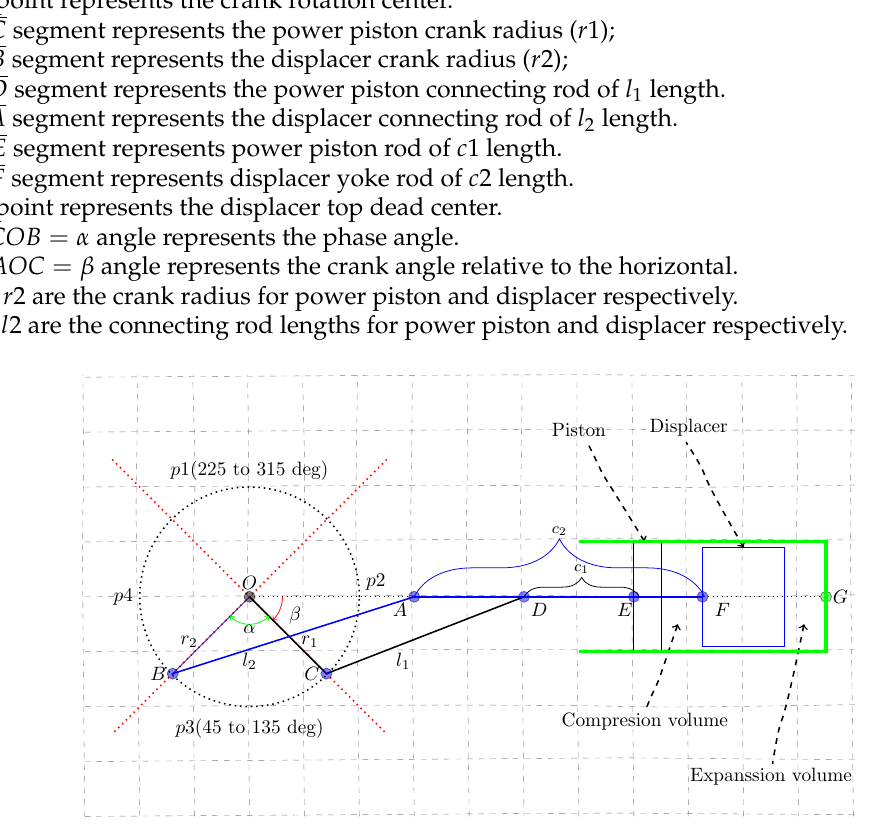
Figure 2. Beta configuration with crankshaft